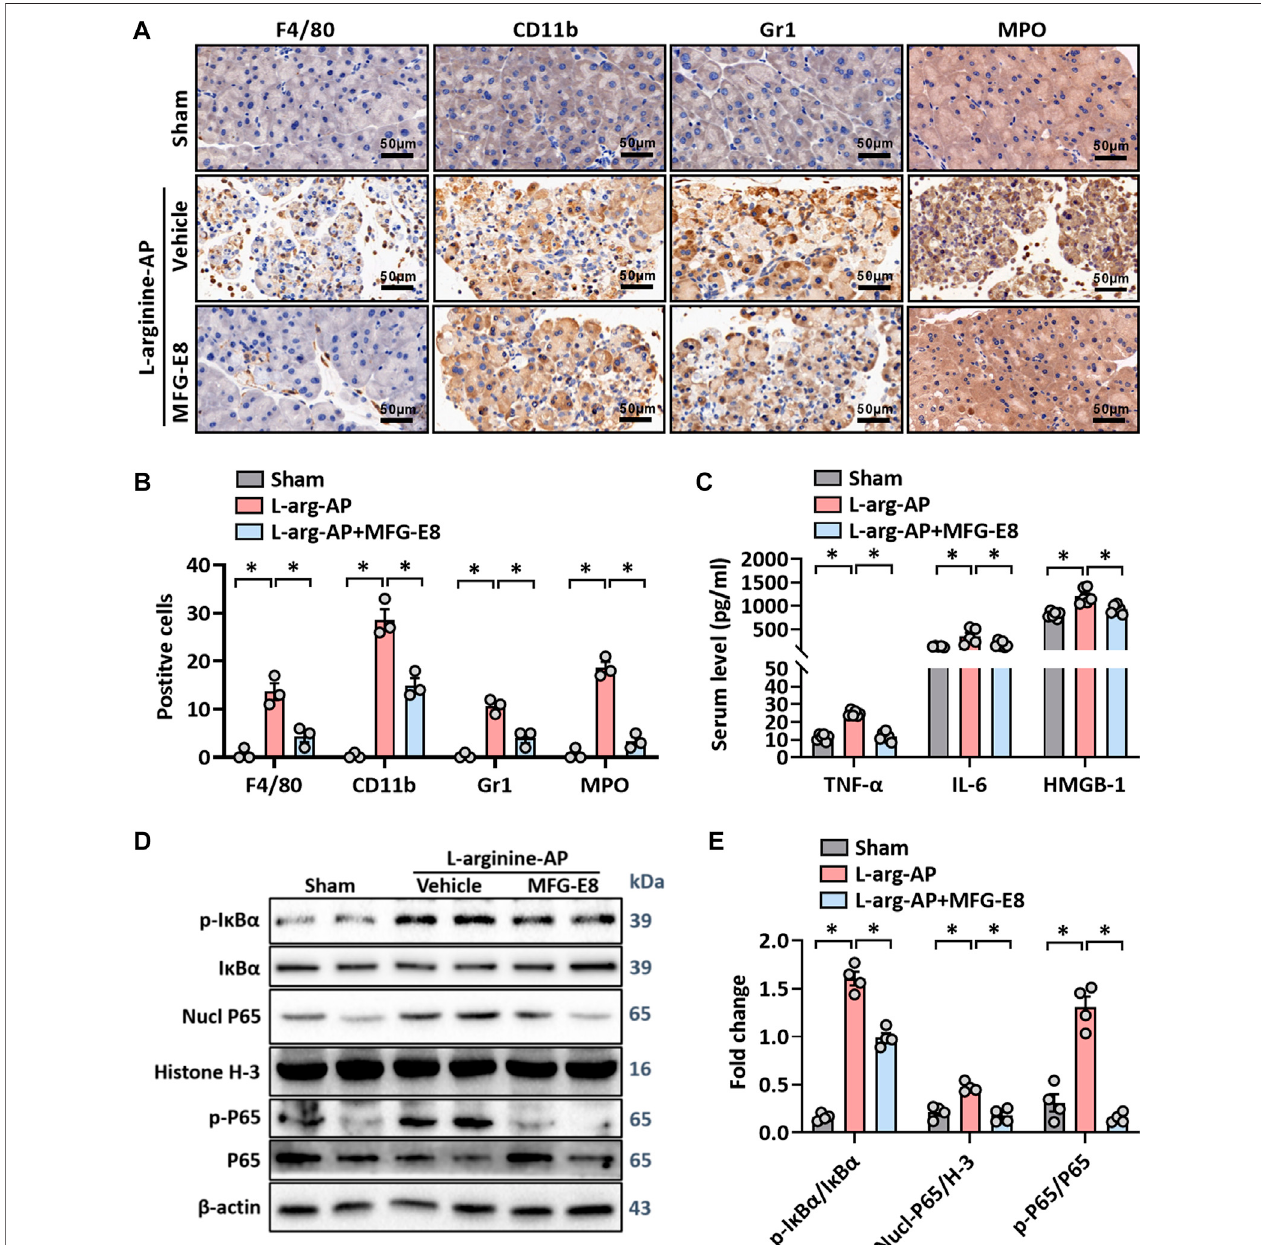
FIGURE 3 | MFG-E8 alleviates the in fl ammatory response in experimental-AP through NF- κ B signaling pathway. In mice, arginine-AP stress was induced by 2 h intraperitoneal injections of 4.0 g/kg L-arginine. At 2 h after the last injection of L-arginine, normal saline (vehicle) or 20 μ g/kg MFG-E8 were administered through intraperitoneal injection. The animals were sacri fi ced at 69 h after MFG-E8 treatment (i.e., 72 h after the fi rst injection of L-arginine). Blood and tissue samples were collected. (A) RepresentativephotosofF4/80,CD11b,Gr1andMPOstaining; (B) QuantitativeofF4/80,CD11b,Gr1andMPOstaining; (C) SerumTNF- α ,IL-6and HMGB-1 levels; (D,E) Western blot analysis of the expression of phospho-I κ B α , I κ B α , nucl-P65, cyto-P65, nucl-H3 and cyto- β -actin in the pancreas. n (cid:1) 4 – 6/group, error bars indicate the SEM; p p < .05 versus Sham group; # p < .05 versus Vehicle group. MFG-E8, milk fat globule EGF factor 8; AP, acute pancreatitis; MPO, myeloperoxidase; HMGB-1, High mobility group box 1; Nucl, nucleus; Cyto, cytoplasm; H-3, histone-3; I κ B α , inhibitor of NF- κ B- α ; NF- κ B p65, Nuclear Factor Kappa- B p65.